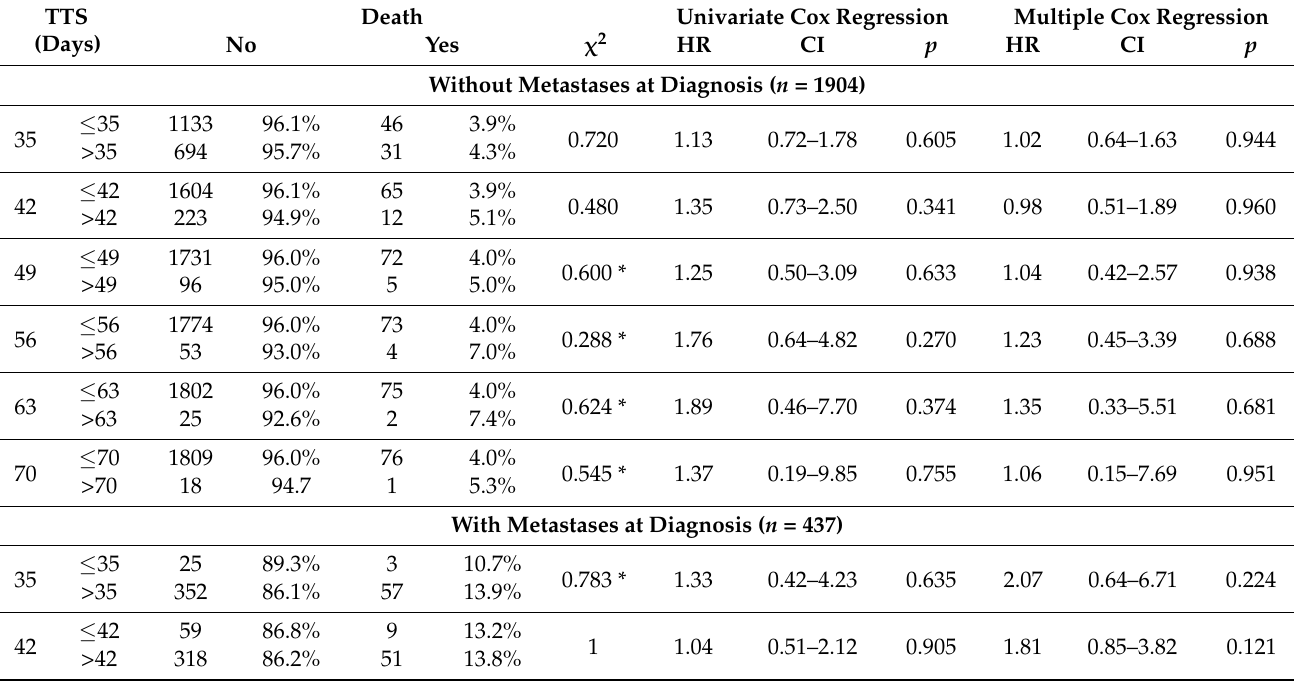
Table 3. Results of univariate und multivariate regression analysis of the impact of TTS on OS at different time points for patients with unilateral WT with and without metastases at diagnosis.